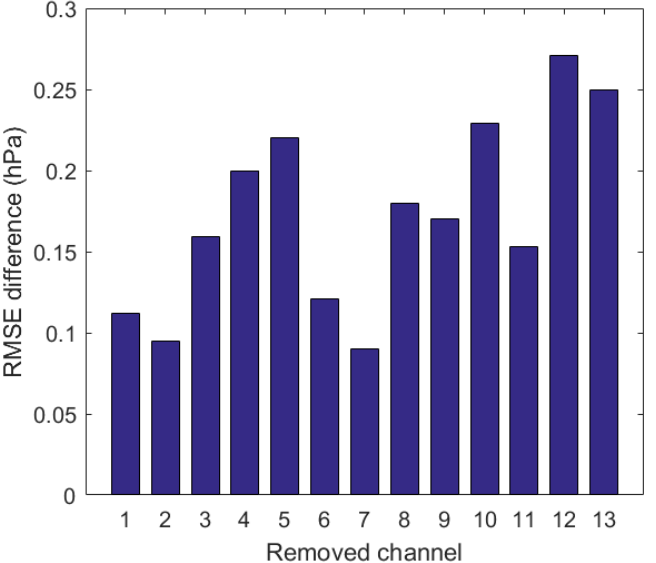
Figure 11. The differences between the SSP retrieval accuracy from MWTS-II and the 13 SSP retrieval accuracies from the MWTS-II channel combination removing one channel.